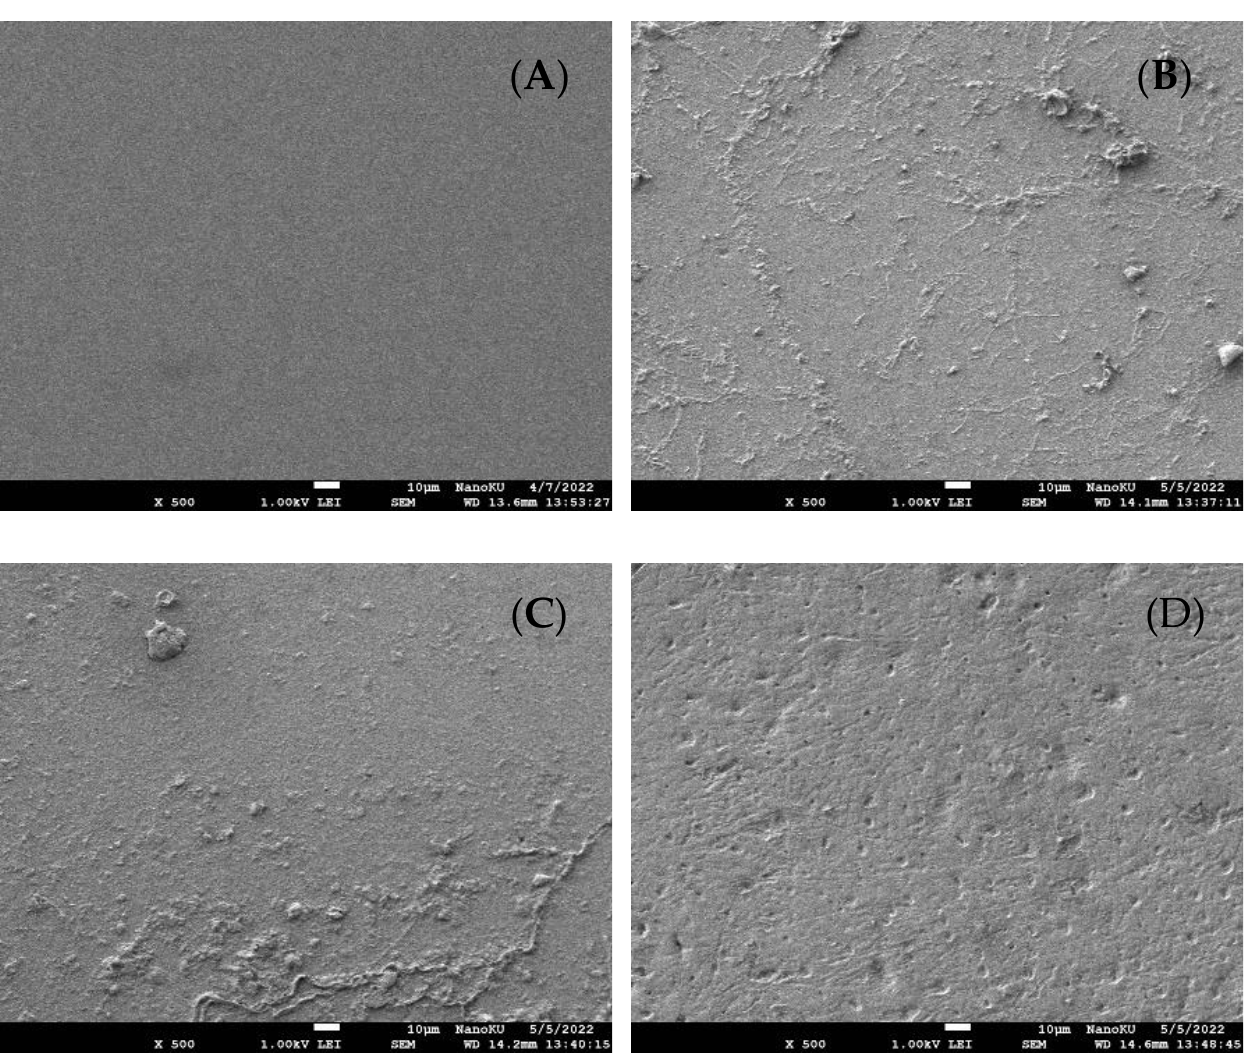
Figure 7. Surface morphology of mulching film (40PVA/60LN) after burial and soil biodegradation at ( A ) 0 days; ( B ) 21 days; ( C ) 28 days; ( D ) 35 days.